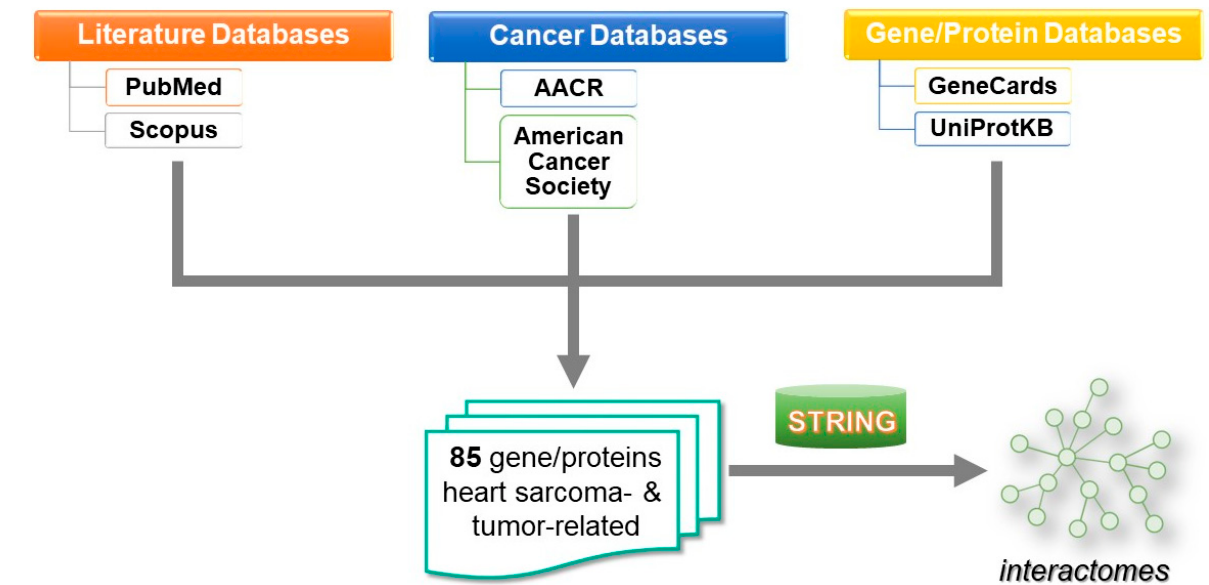
Figure 8. Workflow chart representing the algorithm followed in this work.